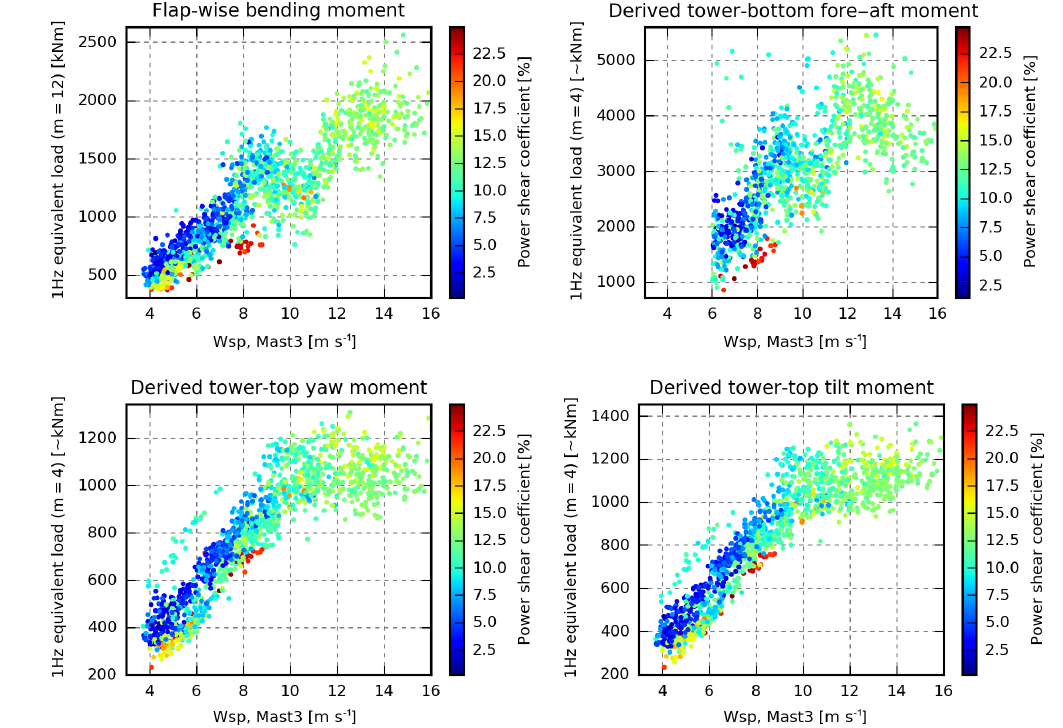
Figure 9. The 1Hz equivalent loads coloured by the magnitude of the power shear coefficient extracted from the main met mast.